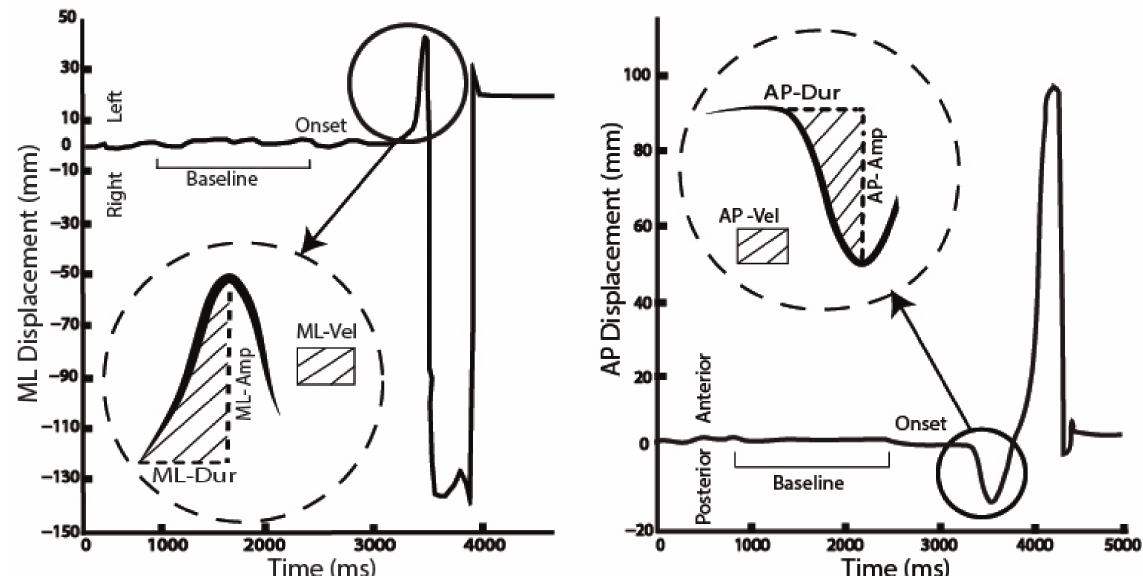
Figure 1. Anticipatory Postural Adjustments (APAs) parameters measured during lateral step (shod condition) in a randomly selected participant. ML ( left ) and AP ( right ) trajectories of the Center of Pressure (CoP) during APAs are represented. Examples of CoP baseline, APAs onset, APAs peak and CoP mean velocity are reported. The six APA parameters are included: Amplitude (ML-Amp; AP-Amp), Duration (ML-Dur; AP-Dur) of time to peak magnitude from onset, and Velocity (ML-Vel;